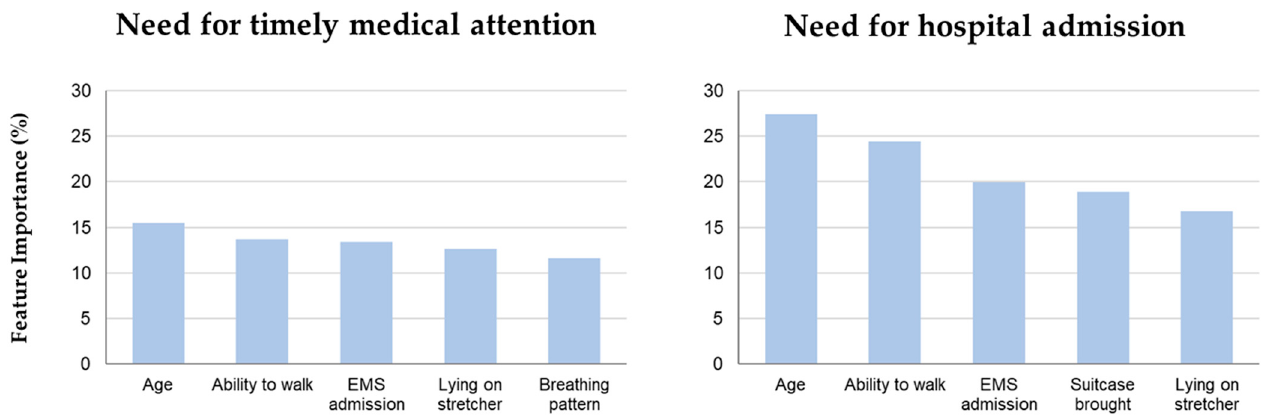
Figure 2. Feature importance of automated machine learning models to predict the need for timely medical attention and the need for hospital admission. EMS, emergency medical services.